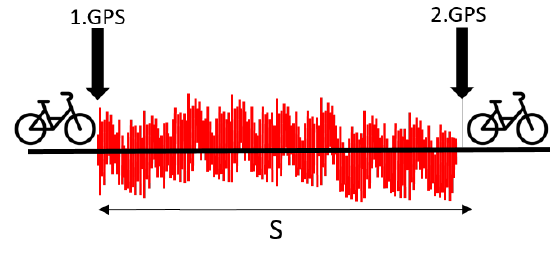
Figure 4. Graphic representation of the IRI. The red bars represent the displacement in